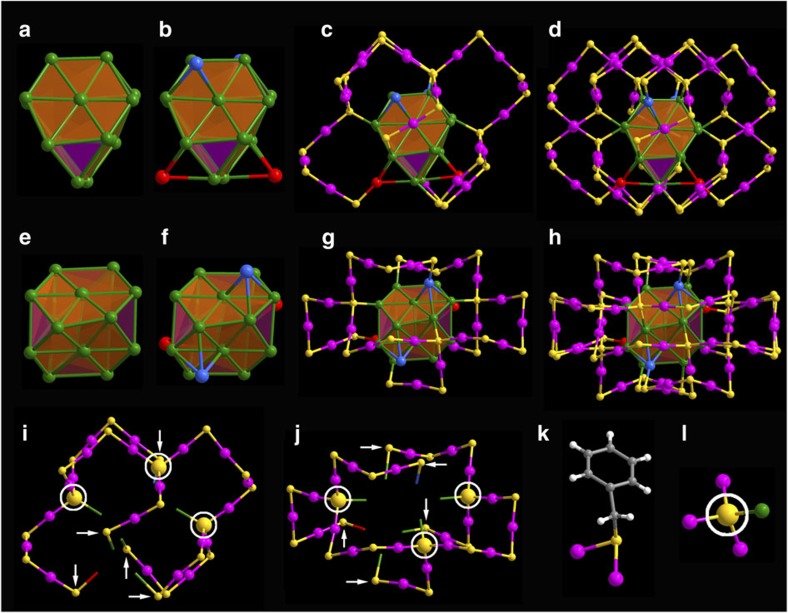
Anatomy of the atomic structure of Au60S6(SCH2Ph)36 nanocluster.(a,e) Side and top view of the Au16 tetrahedron without vertex; (b,f) side and top view of Au20 inner kernel; (c,g) side and top view of Au20 kernel with an Au20S3(SCH2Ph)18 staple motif; (d,h) side and top view of the overall framework of the Au60S6(SCH2Ph)36 nanocluster with a pair of Au20S3(SCH2Ph)18 staple motifs; (i,j) side and top view of the Au20S3(SCH2Ph)18 staple motif; (k) the μ2-S atom and (l) the μ4-S atom (highlighted in the white circle). Colour labels: yellow=S, white=H, gray=C, other colour=Au. The Au atoms are represented in different colours to differentiate from them each other on the bonding ways and occupying positions.